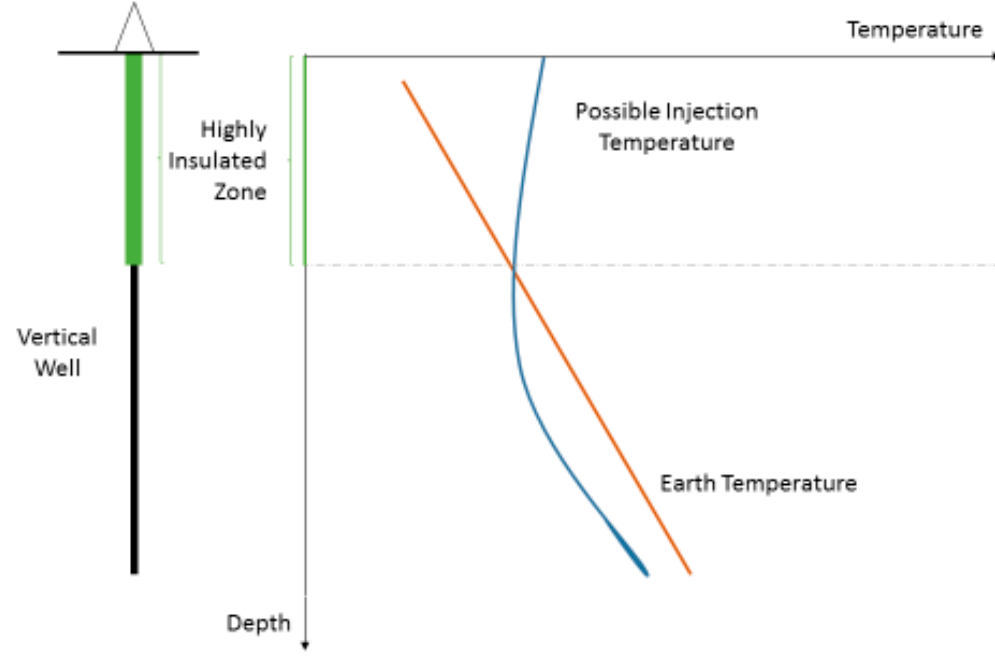
Figure 1. Proposed well construction to enhance temperature of the injection fluid [21].